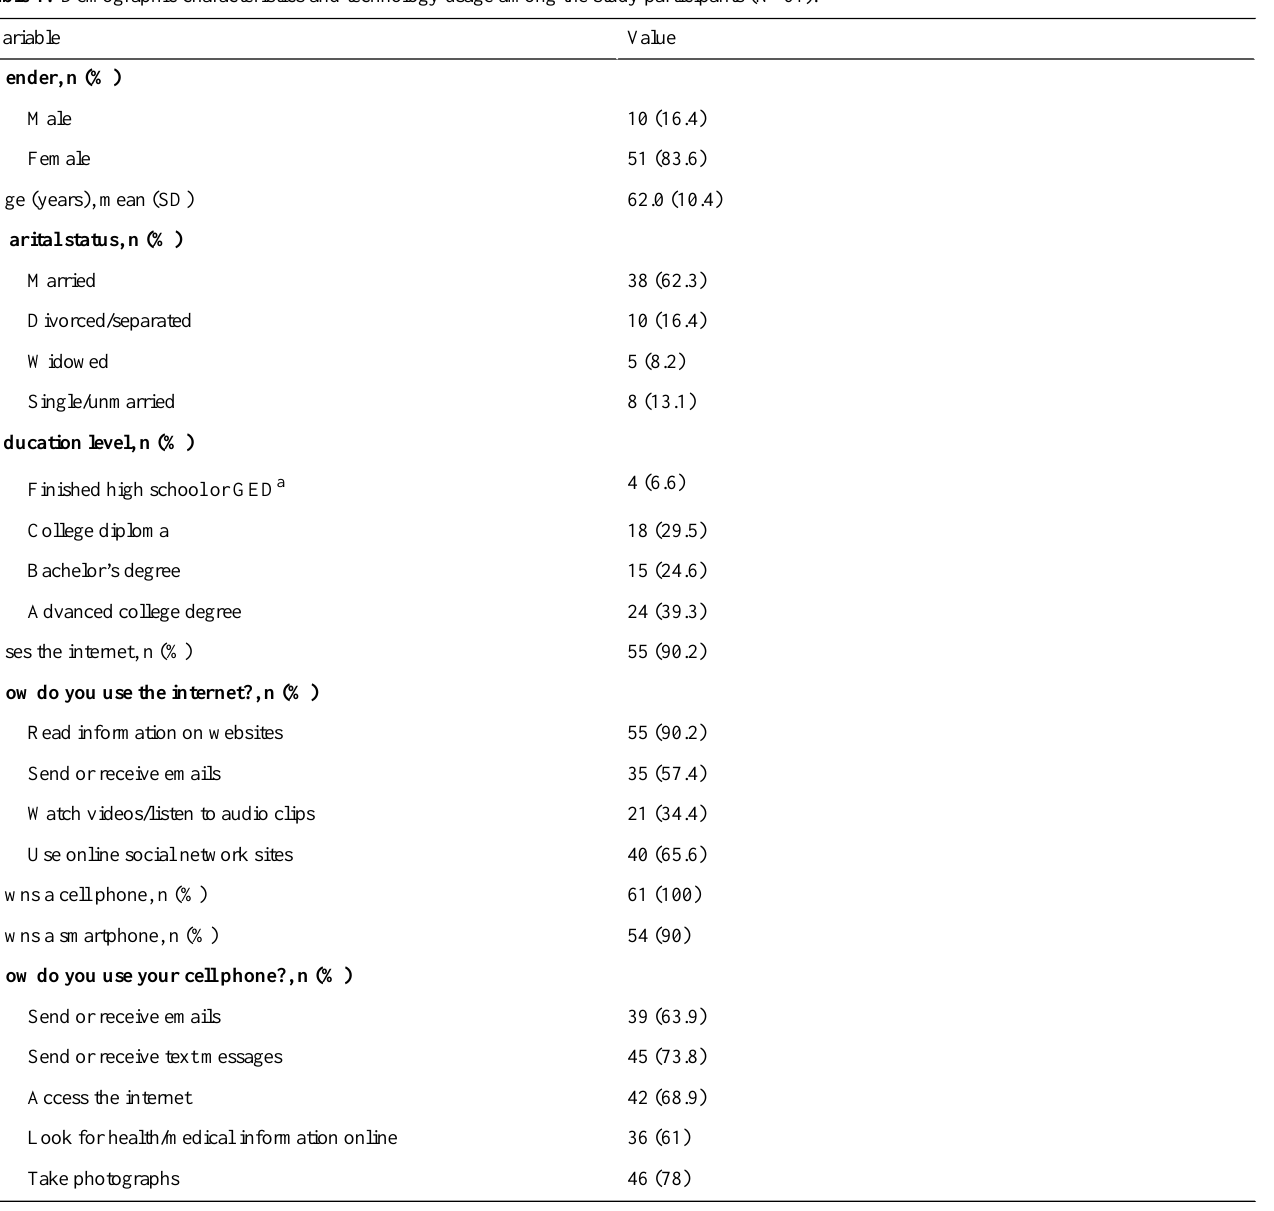
Table 1. Demographic characteristics and technology usage among the study participants